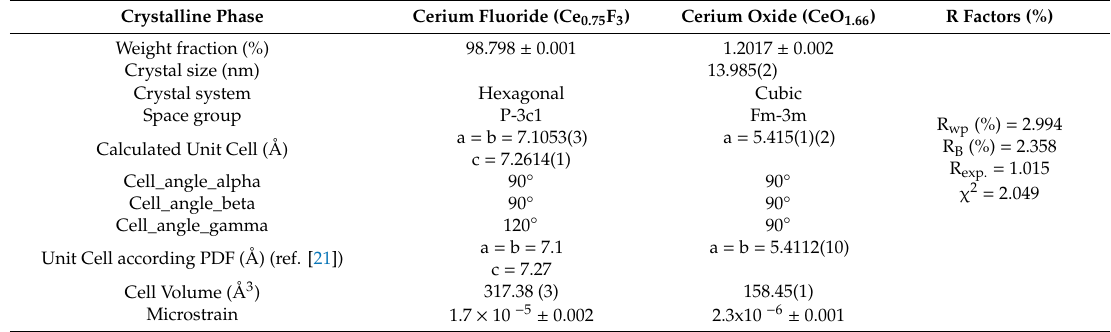
Table 1. Rietveld refinement results for Tb 3 + doped CeF 3 nanocrystalline powders calcinated at 400 ◦ C.